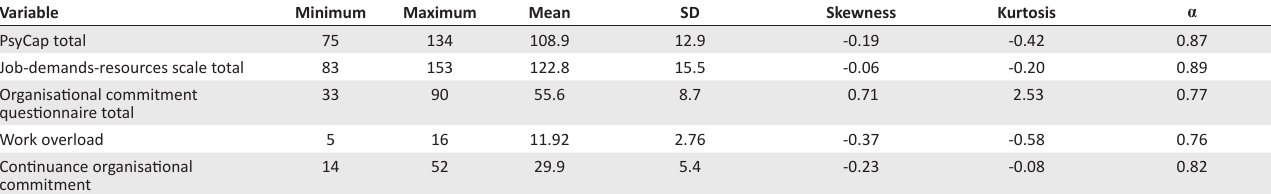
TABLE 3: Descriptive statistics and reliability statistics for the scales. Variable